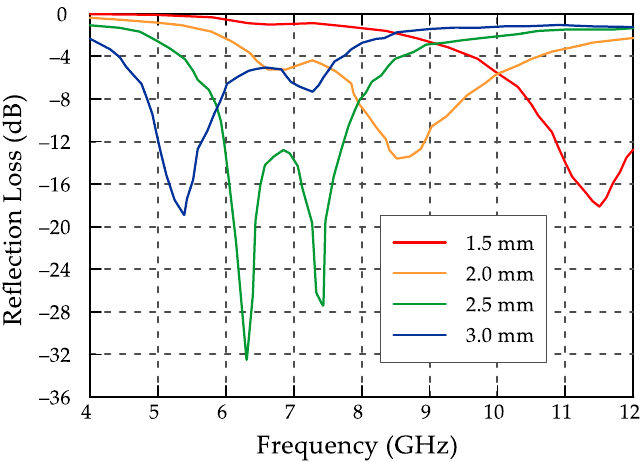
Figure 2. Reflection loss versus frequency for SiC powders coated with Ni-Co-P at different sample thicknesses (based on the data presented in [47]). Table 4. Reflection losses of nickel powder-based material.